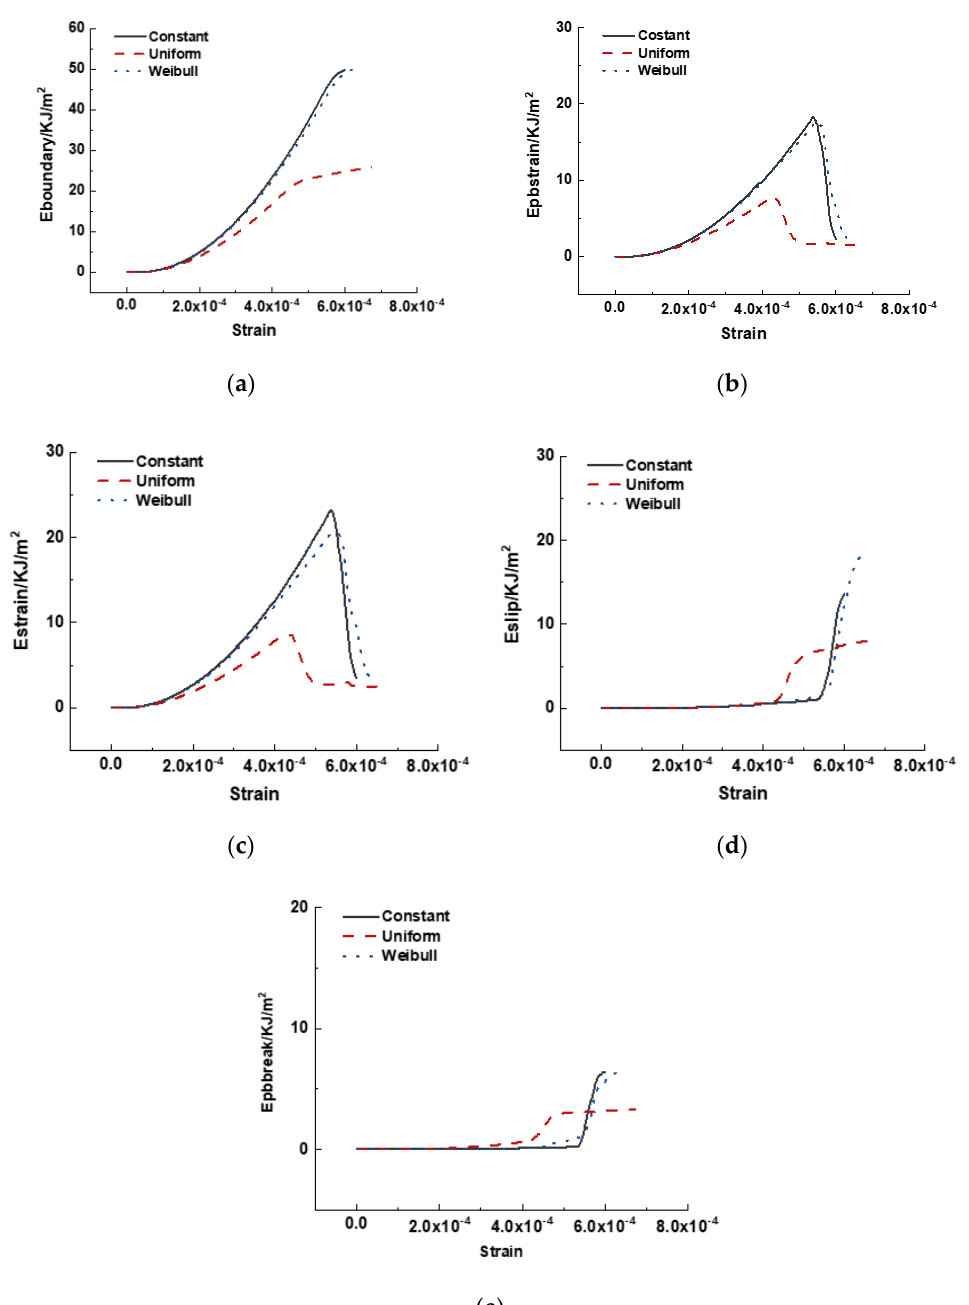
Figure 15. Comparison of energy dissipated by different mechanisms in cases with varying interface properties distribution. ( a ) Eboundary with respect to strain, ( b ) Epbstrain with respect to strain, ( c ) Estrain with respect to strain, ( d ) Eslip with respect to strain, and ( e ) Epbbreak with respect to strain.